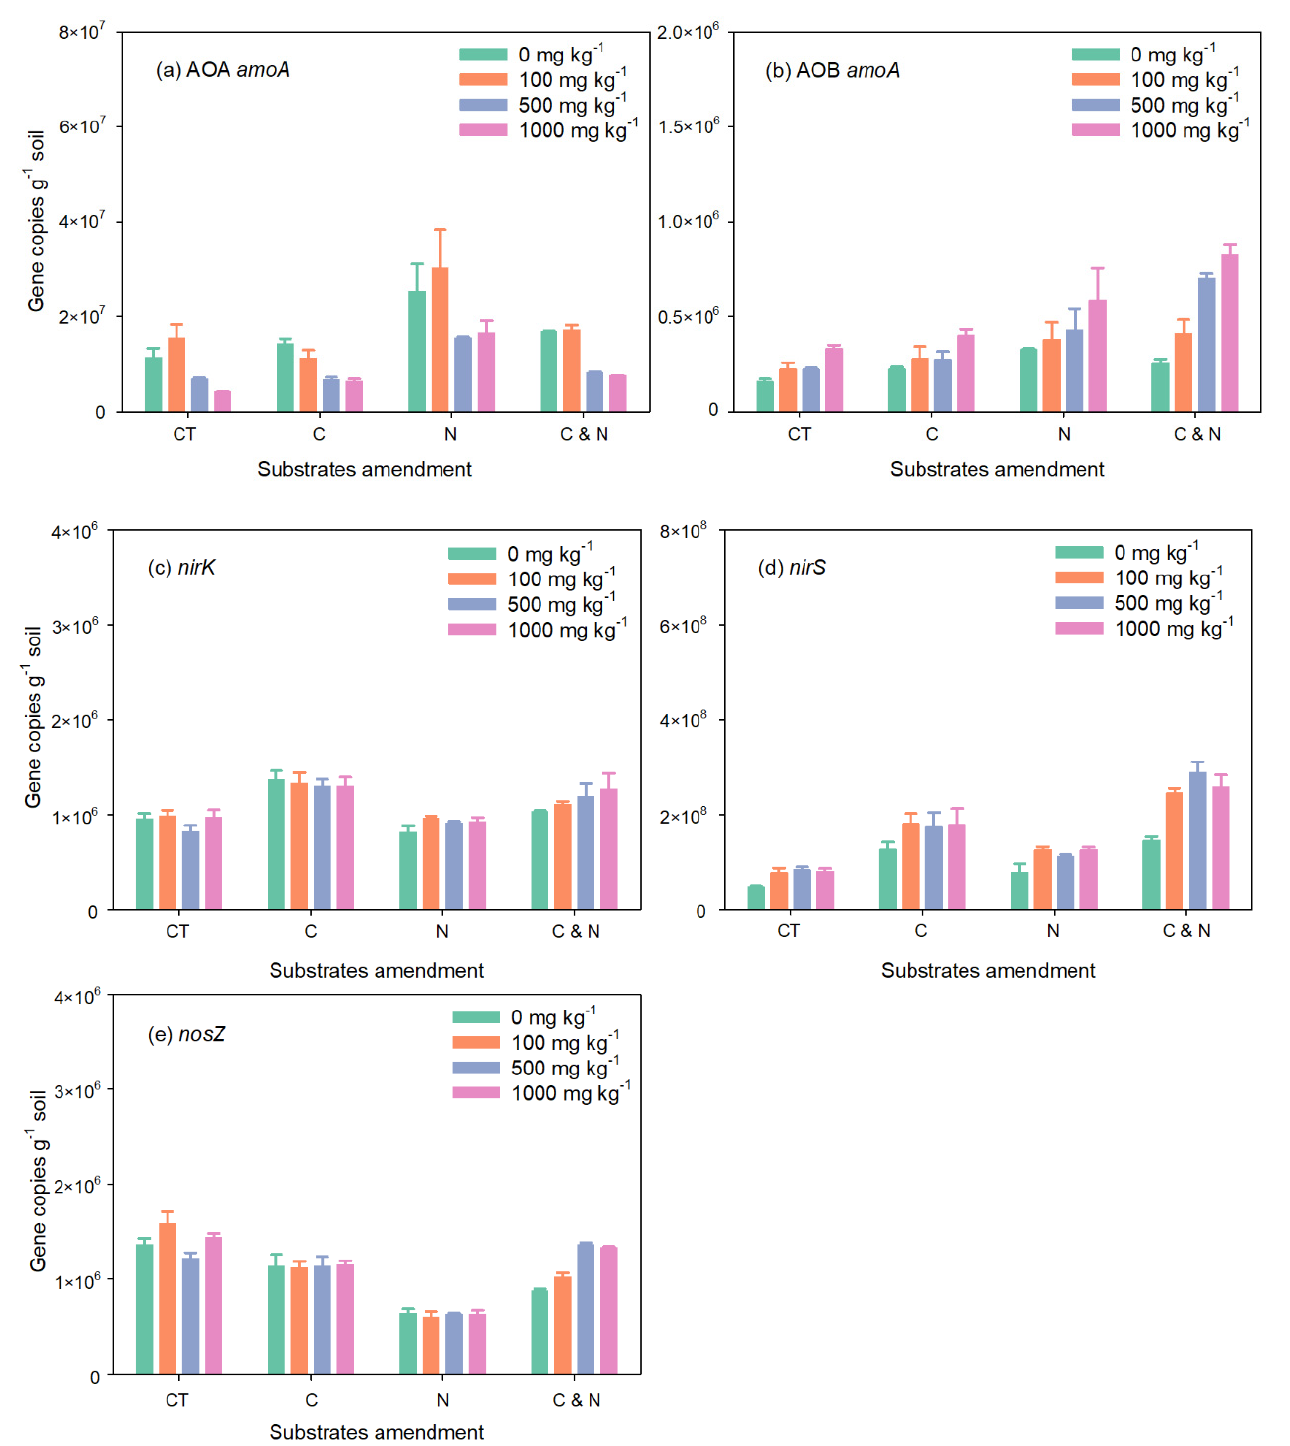
Figure 3. AOA amoA ( a ), AOB amoA ( b ), nirK ( c ), nirS ( d ) and nosZ ( e ) genes under no addition, C addition, N addition, and C and N addition at different ZnO NPs concentrations (0, 100, 500 and 1000 mg kg − 1 ). Error bars represent the standard error of the mean ( n = 3).